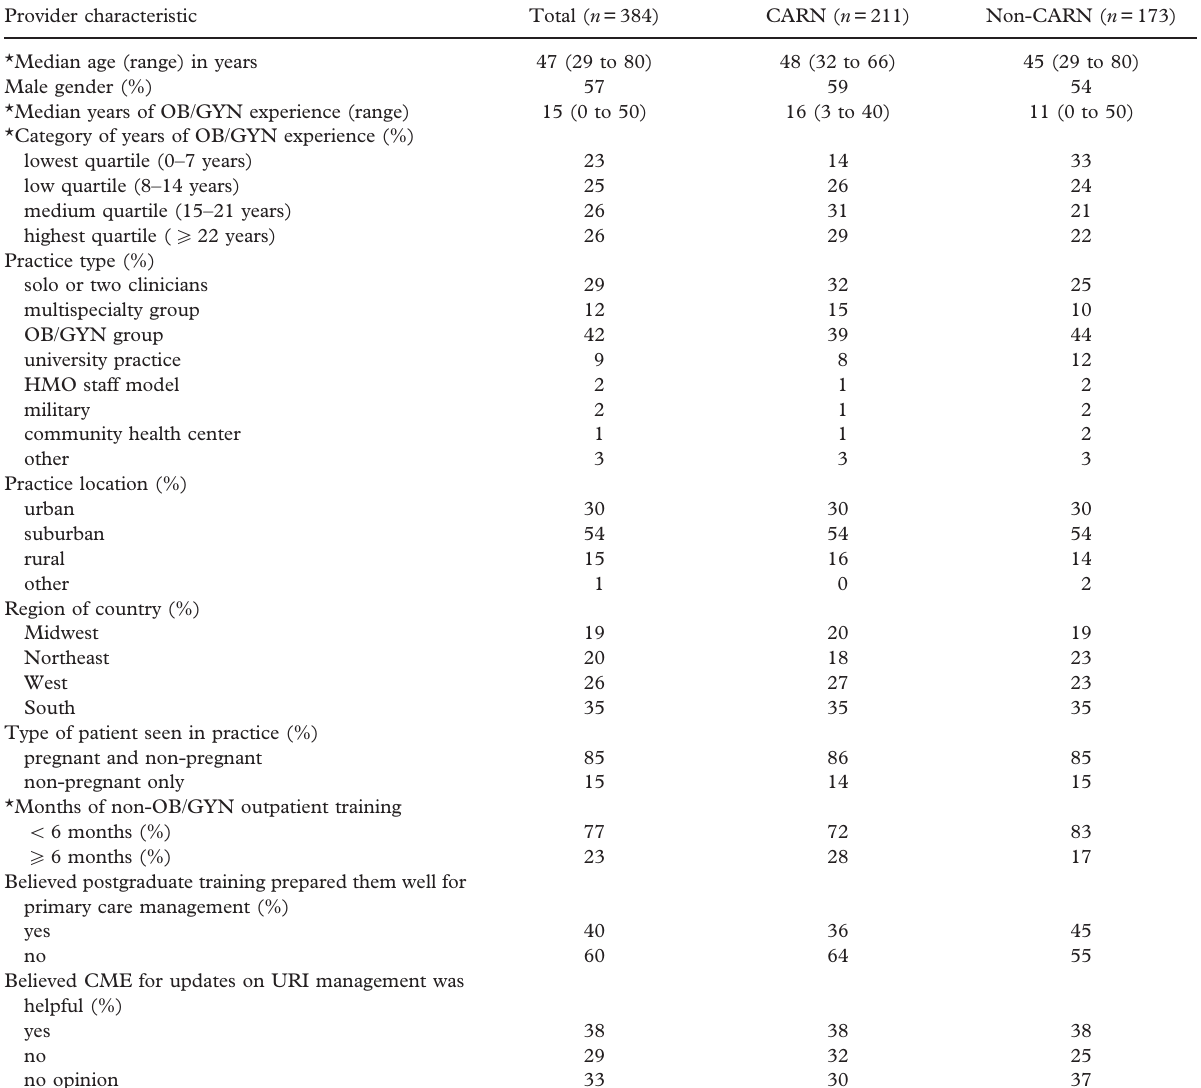
Table I. Characteristics of respondents.